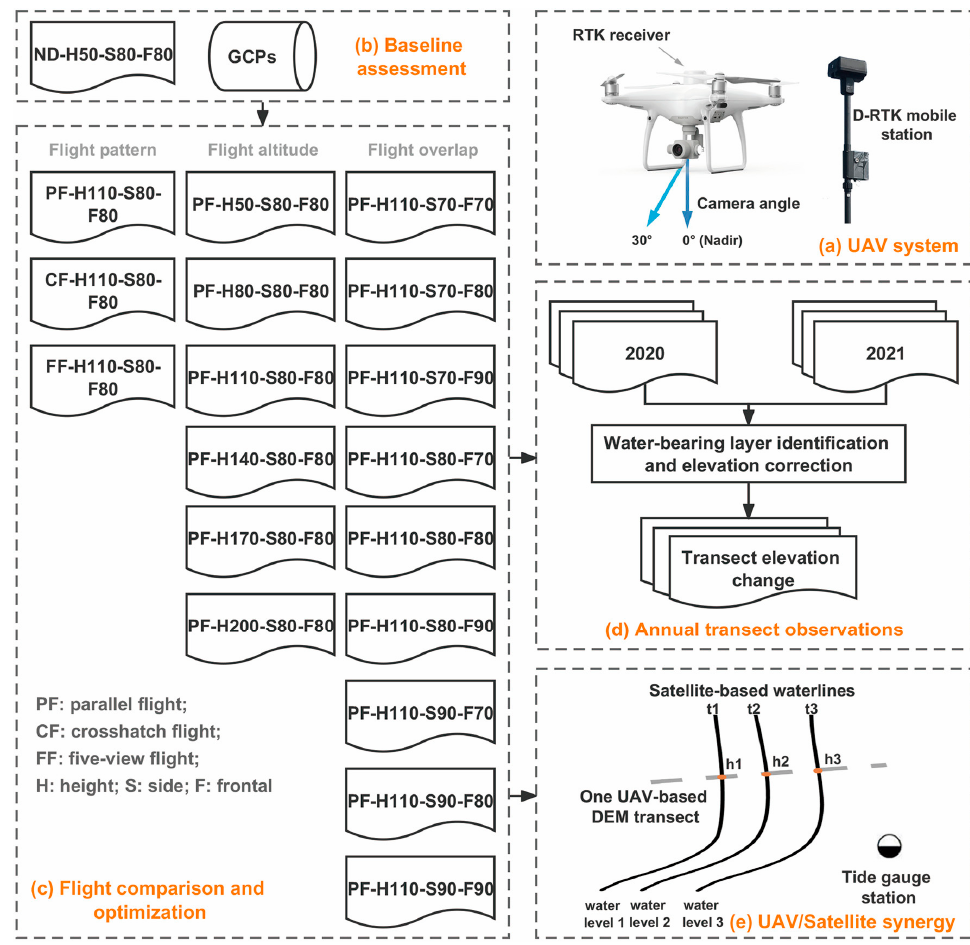
Figure 2. ( a ) The UAV system used in this study; ( b – d ) the workflow for accurate monitoring of mudflat topographic change; and ( e ) the schematic diagram of UAV/satellite synergy for mapping mudflat topography.